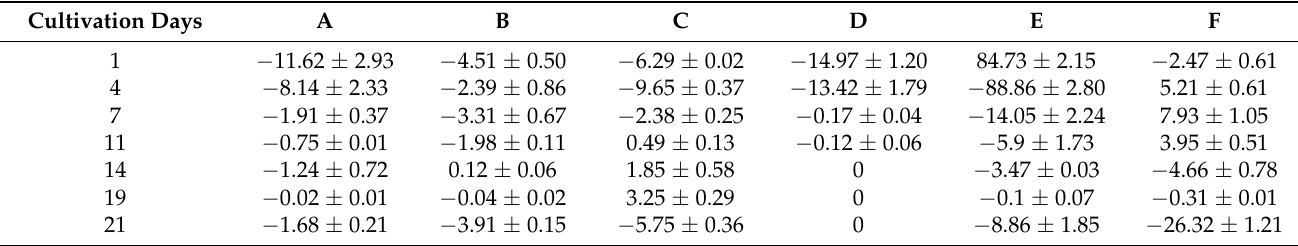
Table 1. Variations in chlorophyll a increment, respectively. The A, B, C, D, E, and F treatments underwent the addition of Fe 3+ , Al 3+ , 3 mol/L zinc (Zn 3 ), 10 mol/L zinc (Zn 10 ), Eucalyptus leaves (EL), and pure water, respectively. There were significant differences among treatments and culture days, respectively ( p < 0.05).